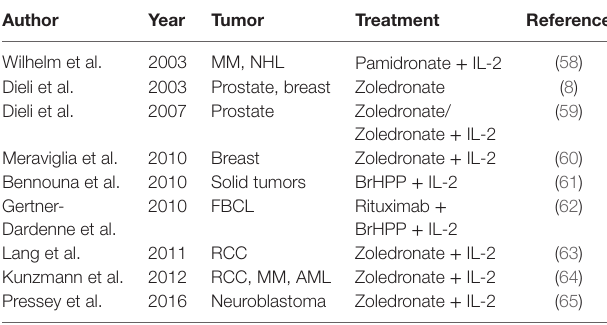
TABLe 1 | Survey of clinical trials based on in vivo activation of γδ